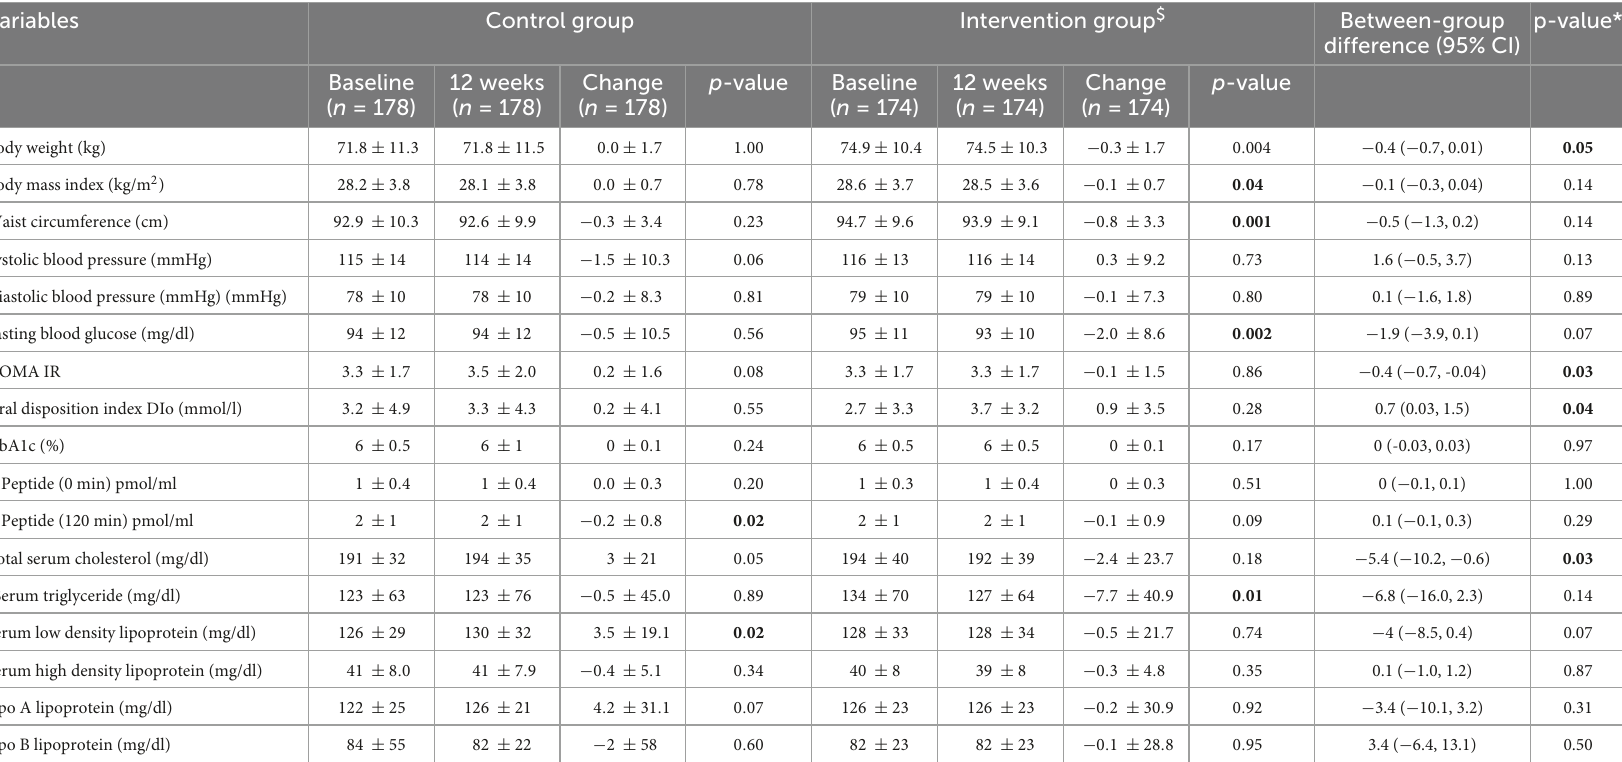
TABLE 1 Mean change in anthropometric, biochemical and dietary characteristics of the study participants ( n = 352).